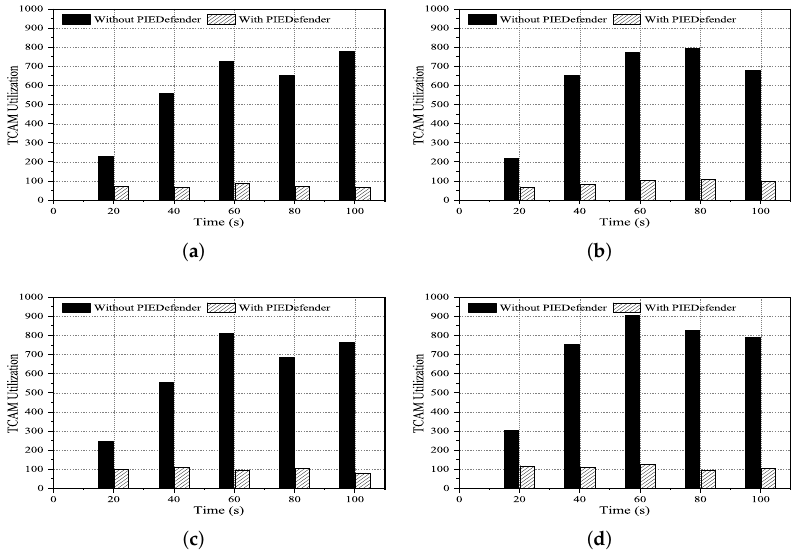
Figure 10. Comparison of switch ternary content addressable memory (TCAM) utilization with and without PIEDefender. ( a ) 50 hosts. ( b ) 100 hosts. ( c ) 150 hosts. ( d ) 200